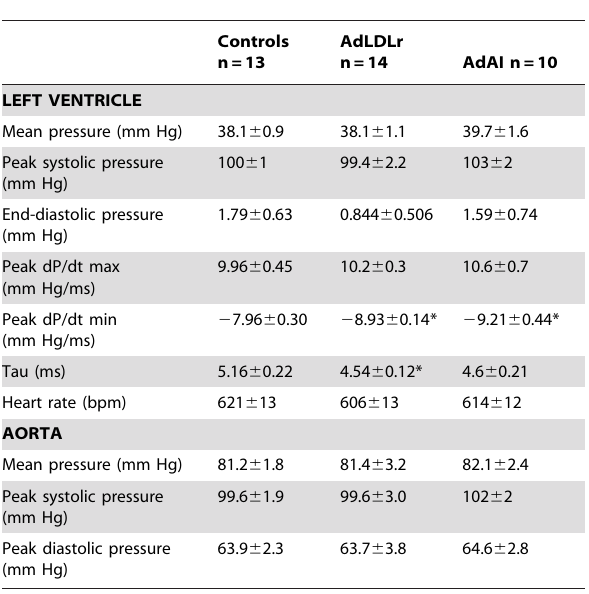
Table 3. Hemodynamic parameters in C57BL/6 LDLr 2 / 2 mice 6 weeks after saline injection or gene transfer with Adnull (controls), gene transfer with AdLDLr, and gene transfer with AdA-I.